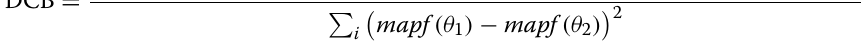
(P i λ i S i 2d ion )/λ i , i = − −